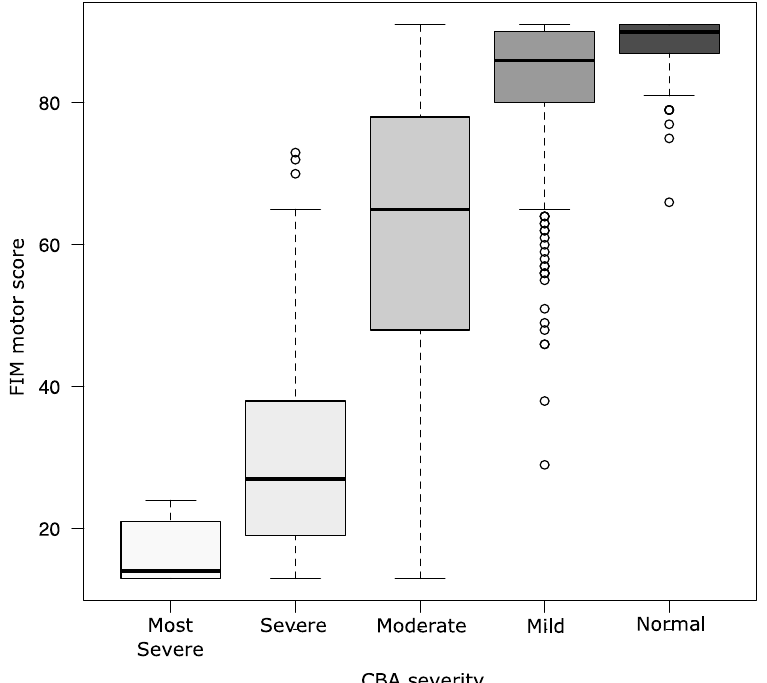
Data are presented as median (interquartile range) or number (percentage). CBA—Cognitive-re- lated Behavioral Assessment. * Other: bilateral strokes and cerebellar/brainstem damage.